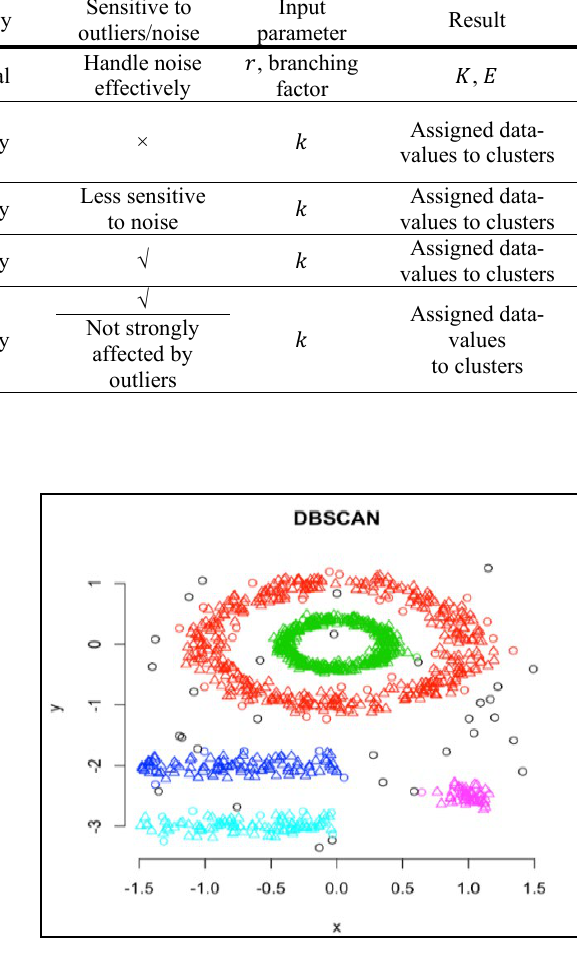
Table 2. Properties of Hierarchical Algorithms